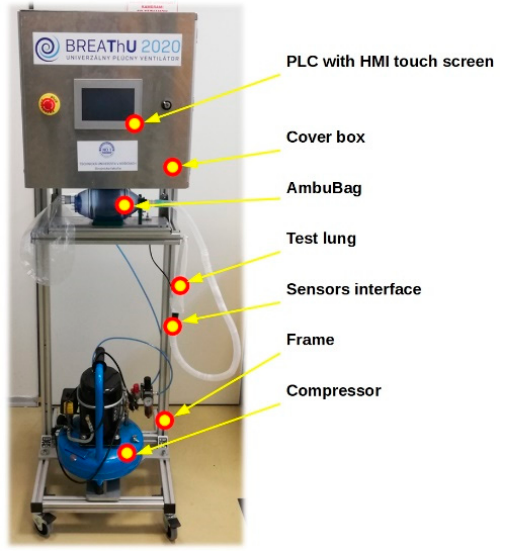
Figure 2. Mechanical ventilator BreaThU.